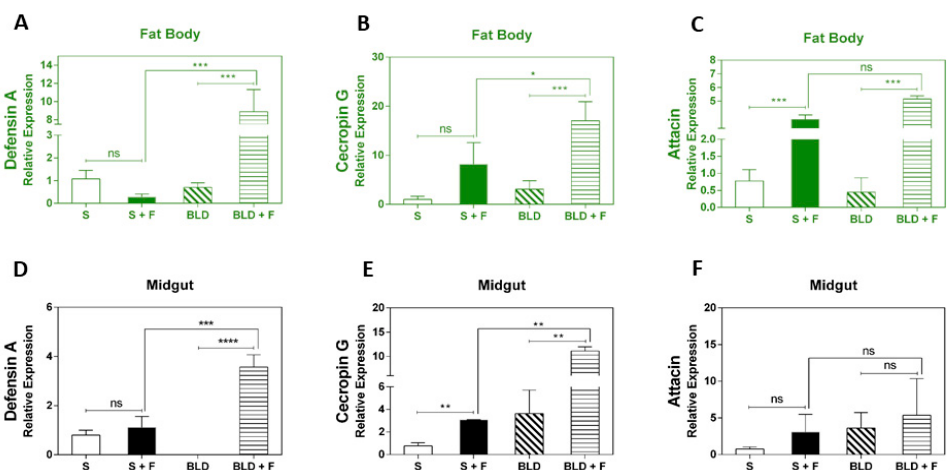
Figure 5. Expression analysis of antimicrobial peptides genes following infection with M. anisopliae . Gene expression analyses of defensin A, cecropin G and attacin in the midgut and fat body of sugar-fed or blood-fed at 48 h post-infection. The insects were fed with sucrose (10%) or mouse blood. Immediately after feeding, the mosquitoes were sprayed with 0.05% Tween 80 with or without M. anisopliae. Forty-eight hours post-infection, total RNA was extracted from mosquitoes, cDNA obtained, and RT-qPCR analyses were subsequently performed. Each bar represents the results from a pool of 15 female mosquitoes. The p- values from pair-wise comparisons (comparing Tween treated to sugar-fed/blood-fed) were calculated using Student’s t -test and levels of significance were indicated for each bar (* p < 0.05; b: ** p < 0.01; *** p < 0.001; **** p < 0.0001). Negative controls were treated with 0.05% aqueous Tween 80.